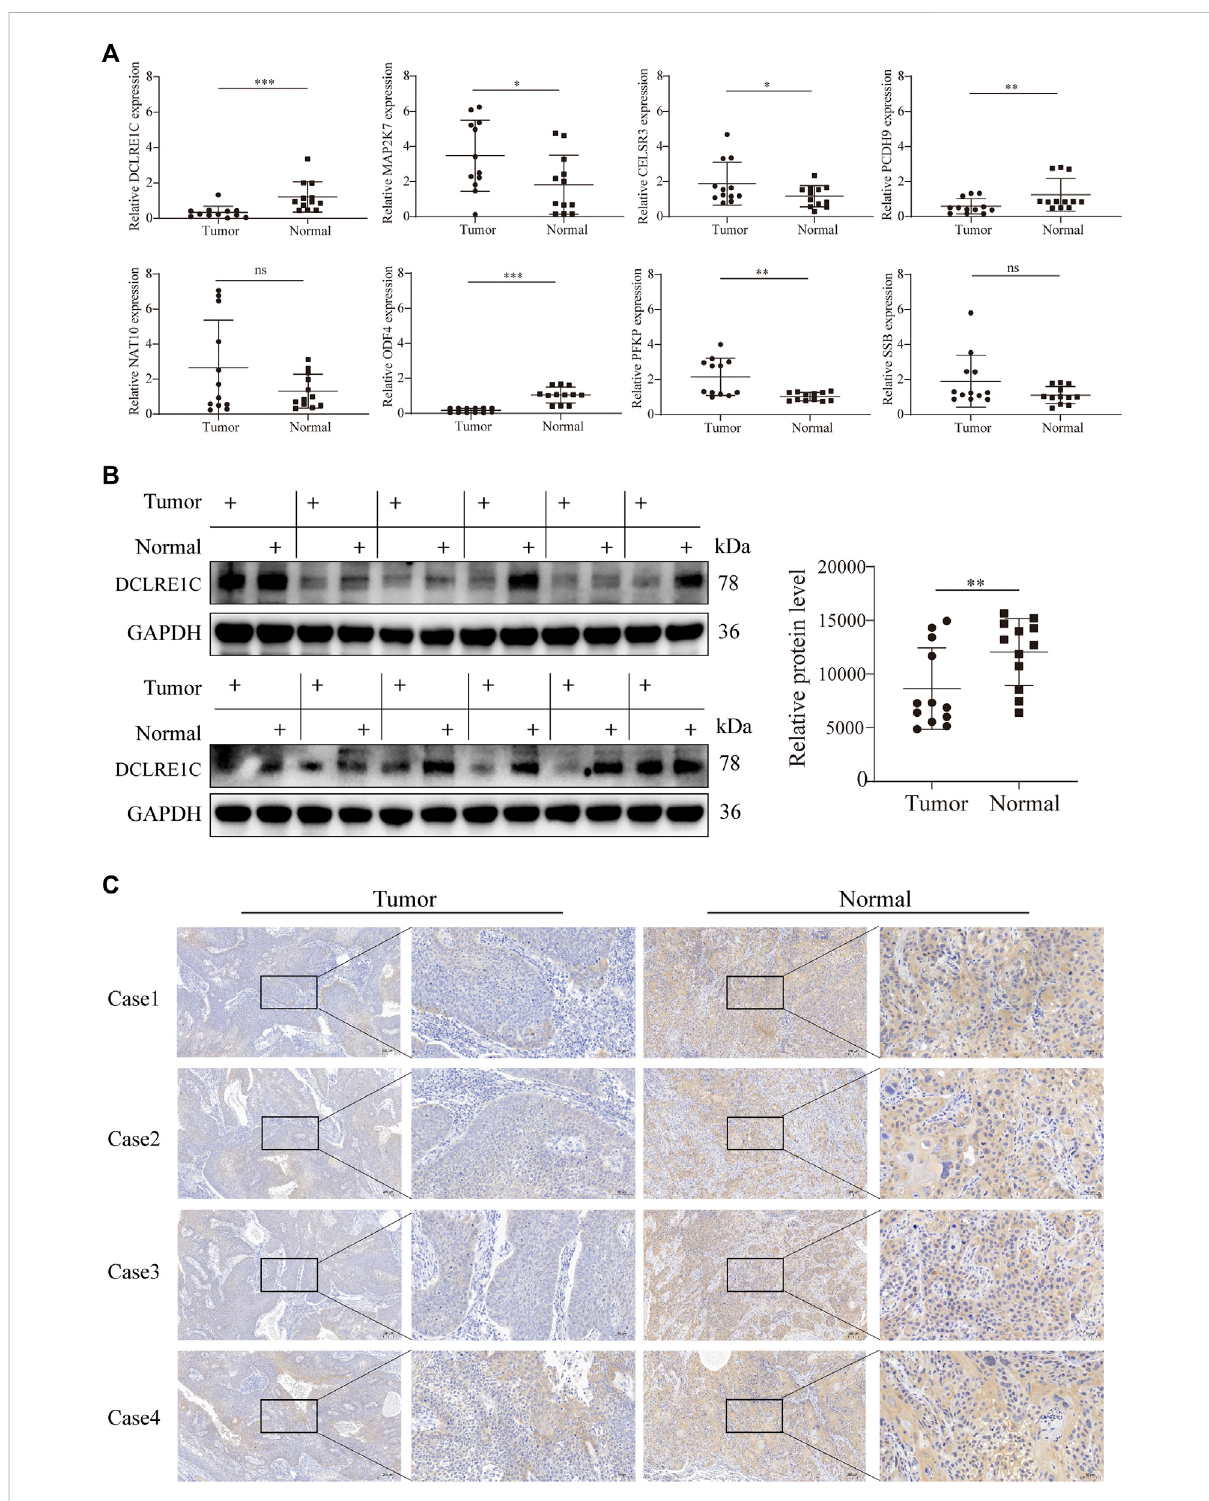
FIGURE 8 DetectionofgeneexpressionintissuesamplesusingqRT-PCR,WBandIHC. (A) qRT-PCRanalysisofmRNAlevelsintumorandadjacentnormal tissues. (B,C) Western blotting, immunohistochemistry analysis of DCLRE1C protein levels in tumor and adjacent normal